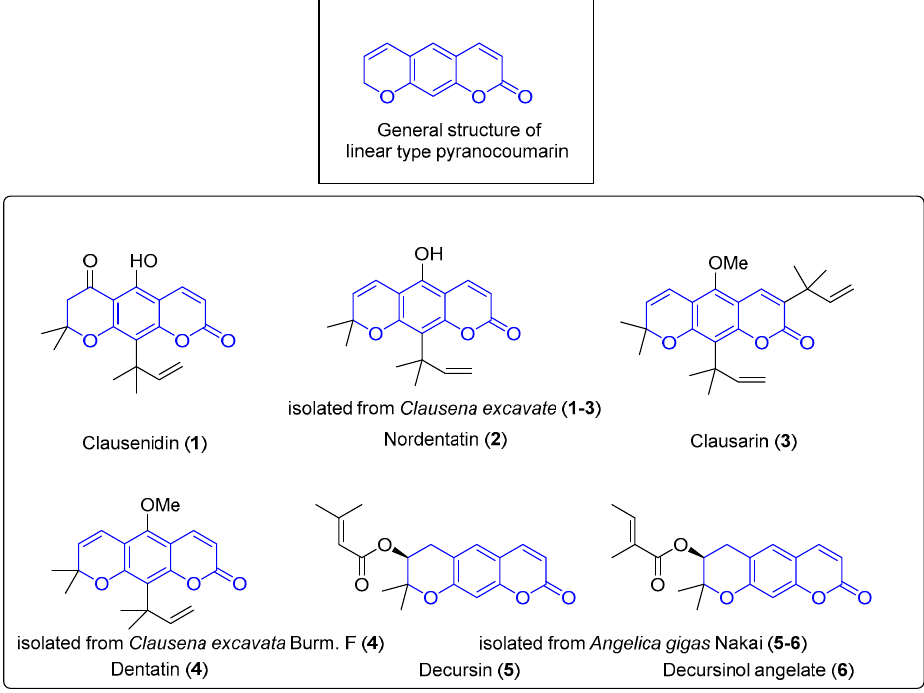
Figure 1. Chemical structures of some linear-type Figure. 1 Chemical structures of some linear-type pyranocoumarins.